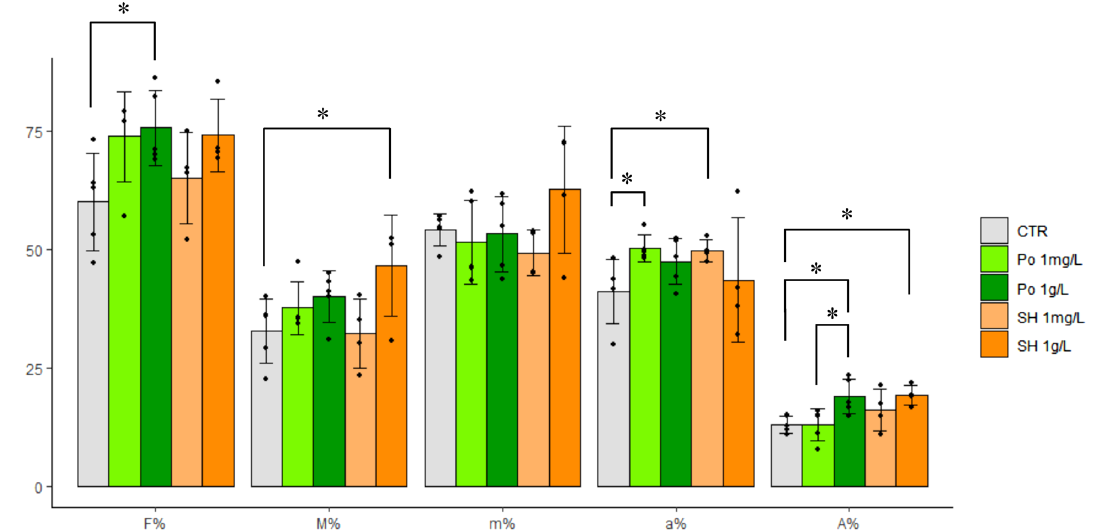
Figure 4. Quantitative analysis of fungal colonization in mycorrhizal M. truncatula roots treated with different CO solutions. A general promotion of fungal colonization was induced by all treatments. In more detail, the application of 1 g/L COs from P. ostreatus (Po 1 g/L) induced a significant increase in colonization frequency (F%) and arbuscule abundance in the whole root system (A%) compared to water-treated controls. A comparable increase in F% was also obtained using a 1 mg/L solution (Po 1 mg/L), which also produced a significant increase in arbuscule abundance in the colonized areas (a%). By contrast, shrimp-derived